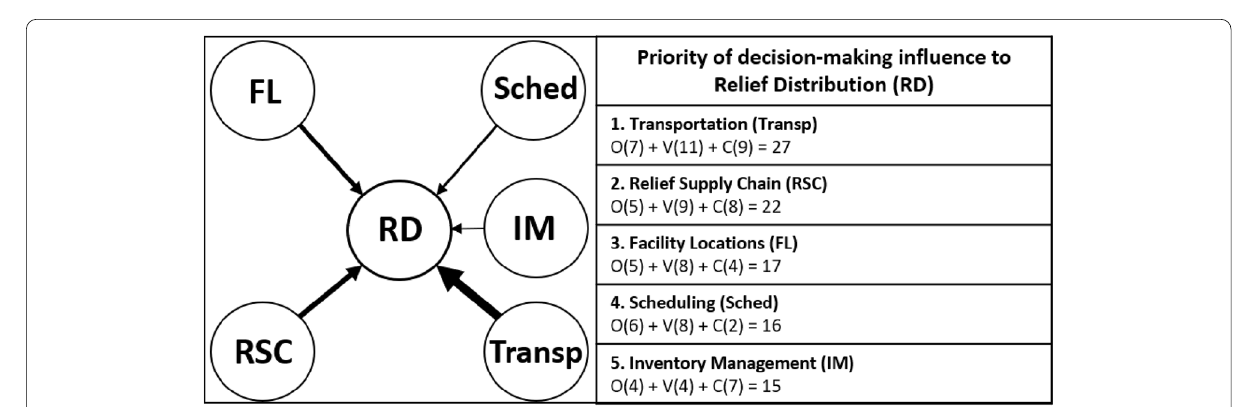
Fig. 6 The final operational ecosystem for relief